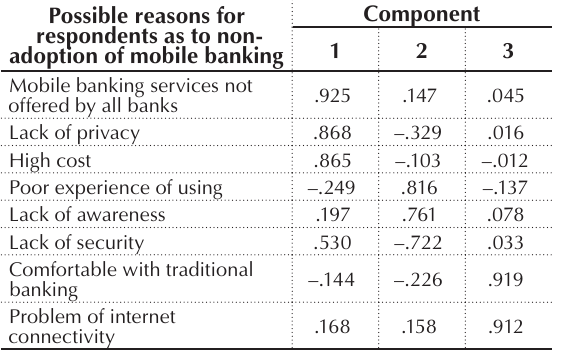
Table 13. (cid:87)(cid:381)(cid:400)(cid:400)(cid:349)(cid:271)(cid:367)(cid:286)(cid:3)(cid:396)(cid:286)(cid:258)(cid:400)(cid:381)(cid:374)(cid:400)(cid:3)(cid:296)(cid:381)(cid:396)(cid:3)(cid:396)(cid:286)(cid:400)(cid:393)(cid:381)(cid:374)(cid:282)(cid:286)(cid:374)(cid:410)(cid:400)(cid:3)(cid:3)